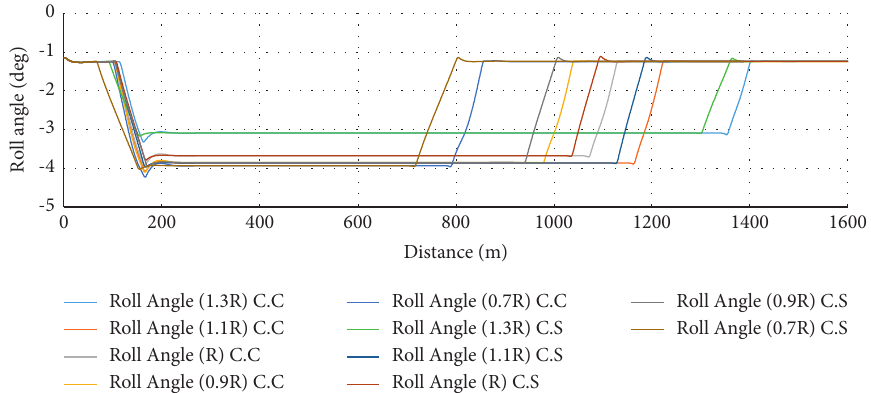
Figure 16: The roll angle versus path length for various radii of the simple and spiral horizontal curves; C.C is the simple horizontal curve, and C.S is the spiral horizontal curve.